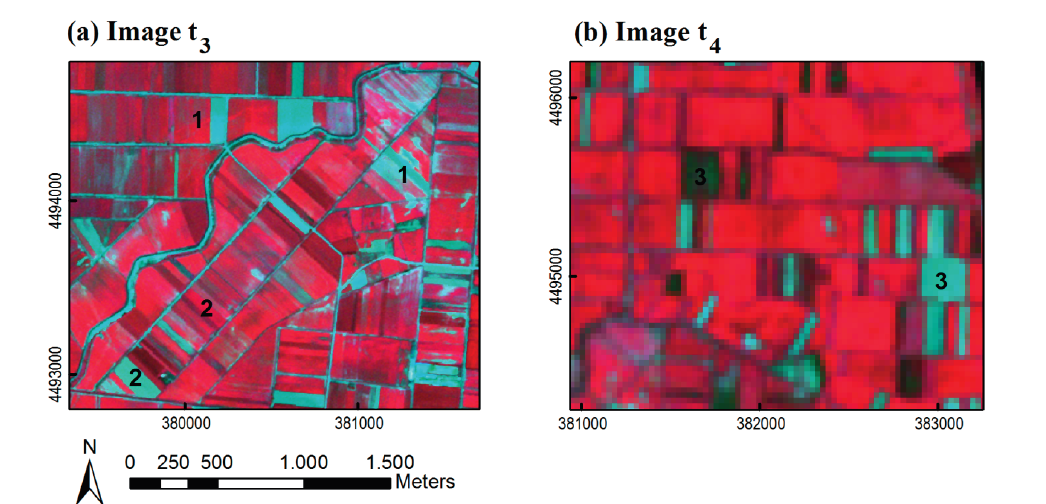
Figure 6. Different subsets of satellite images t 3 and t 4 containing parcels with various crop types (1 = cotton, 2 = alfalfa and 3 = maize). In the left subset it can be observed that certain parcels of cotton and alfalfa may resemble according to their phenological state, while other parcels of the same crops can have distinct spectral properties. This can be also observed in the right subset referring to maize fields with different spectral